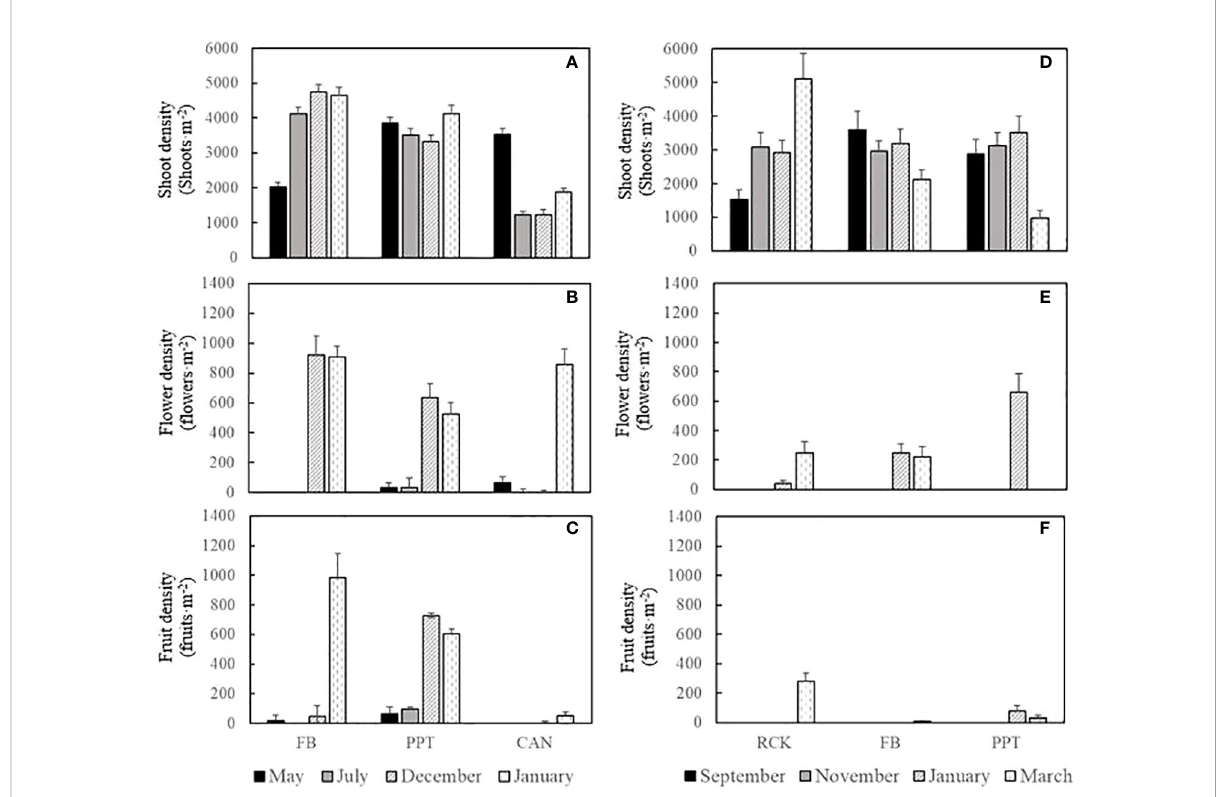
FIGURE 7 The density of H. ovalis shoots and reproductive performance including fl ower and fruit density in the sites (mean ± SE, n=720). (A – C) showed the investigation results in FB, PPT, and CAN during 2014-2015; (D – F) showed the investigation results in RCK, FB, and PPT during